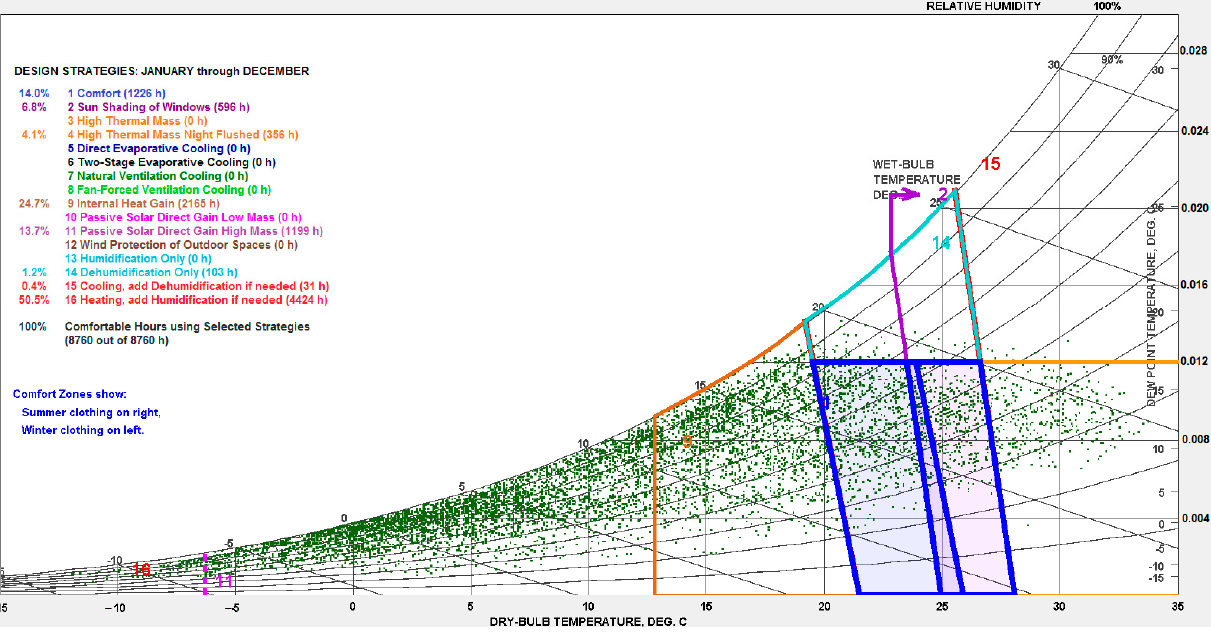
Figure 5. Psychrometric chart for Timi ș oara location (IWEC Data, 152,470 WMO Station): comfortable indoors hours using both active and passive design strategies. Reprinted from [22].